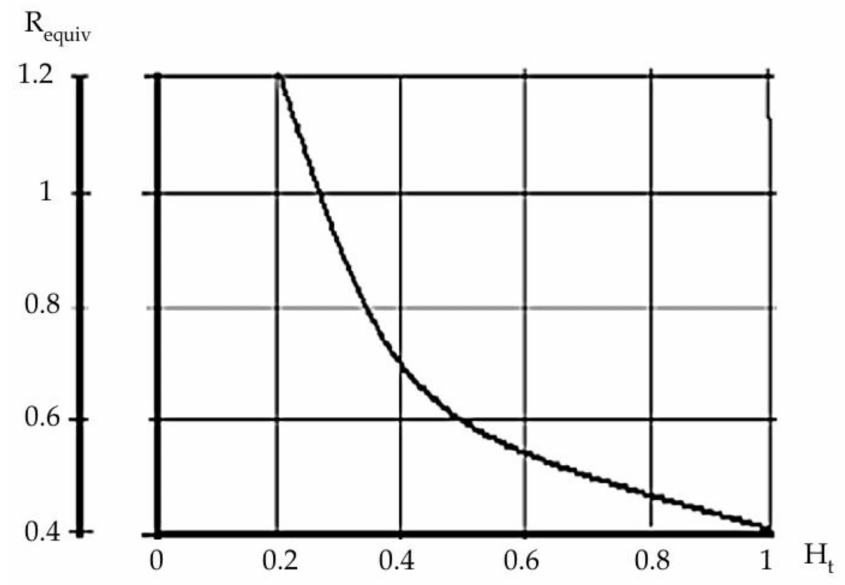
Figure 2. Graph of the dependence of active resistance R equiv on the size of the fill of the crucible in height H t